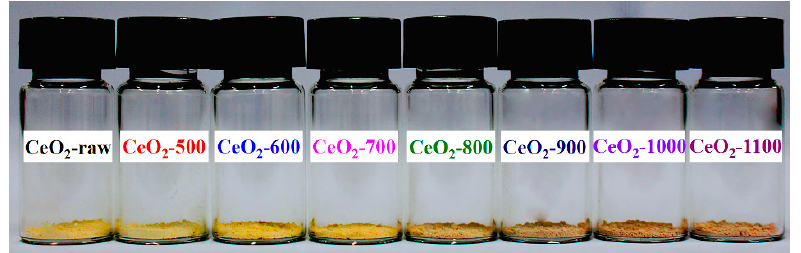
Figure 1. The typical photographs of CeO 2 -raw and as-prepared CeO 2 -x catalysts at different calcination temperatures in Ar.